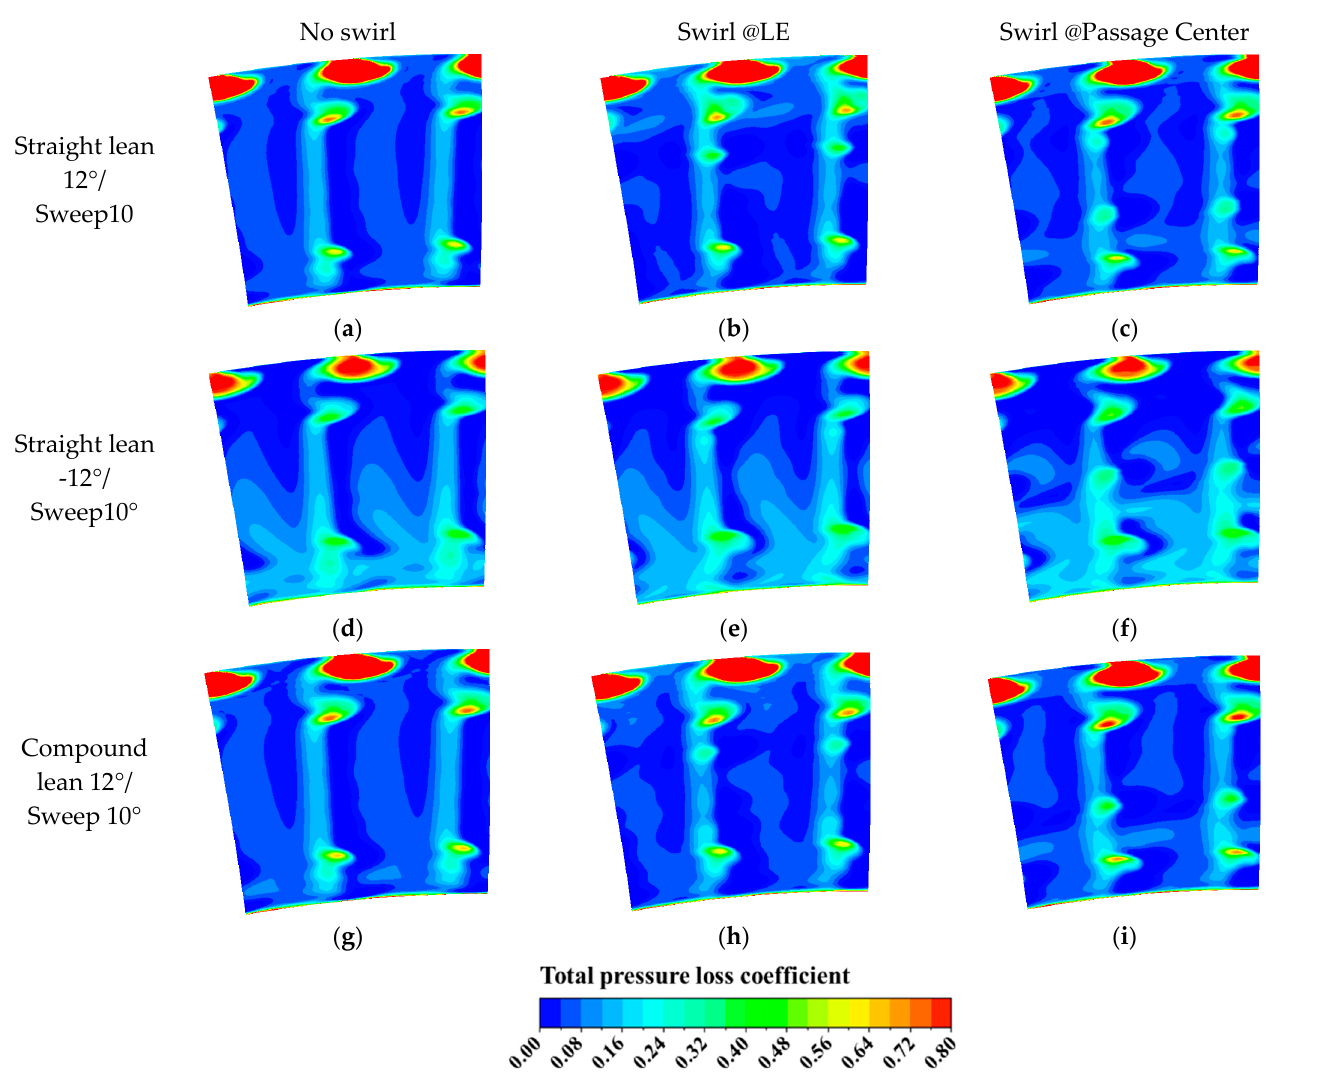
Figure 27. Total pressure loss coefficient at blade exit at z/C ax =1.2 (rear view): ( a ) SL12 SP10 No swirl; ( b ) SL12 SP10 SW@LE; ( c ) SL12 SP10 SW@PC; ( d ) SL − 12 SP10 No swirl; ( e ) SL − 12 SP10 SW@LE; ( f ) SL − 12 SP10 SW@PC; ( g ) CL12 SP10 No swirl; ( h ) CL12 SP10 SW@LE; ( i ) CL12 SP10 SW@PC.